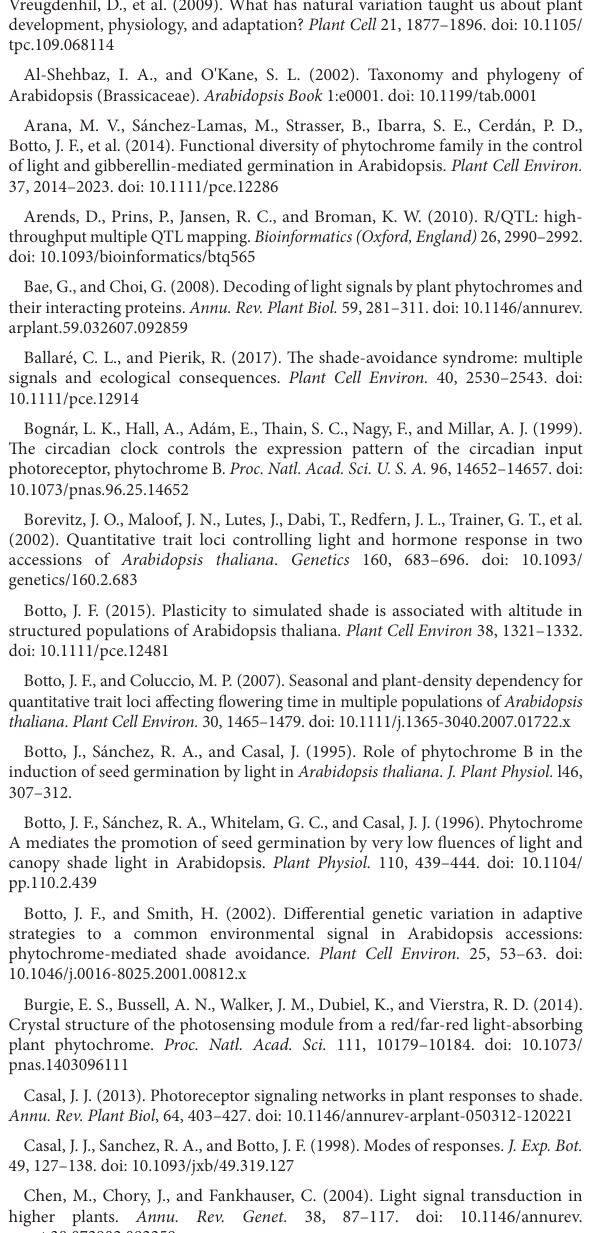
calculated with the parameters obtained in (B). (D) Dot blot of independent transgenic lines for each polymorphism at different dilutions. SUPPLEMENTARY FIGURE S7 Functional variation of PHYB polymorphisms in shade avoidance response (SAR). Hypocotyl length in white light and shade light (A) or the SAR index (B) calculated as the ratio of hypocotyl length in simulated shade and WL for each PHYB polymorphism in independent transgenic lines. Mean ± SE (n=2). SUPPLEMENTARY FIGURE S8 Functional variation of PHYB polymorphisms in seedling de-etiolation response. Hypocotyl length in darkness and red continuous light (A) or the de-etiolation inhibition response (B) calculated as the ratio of